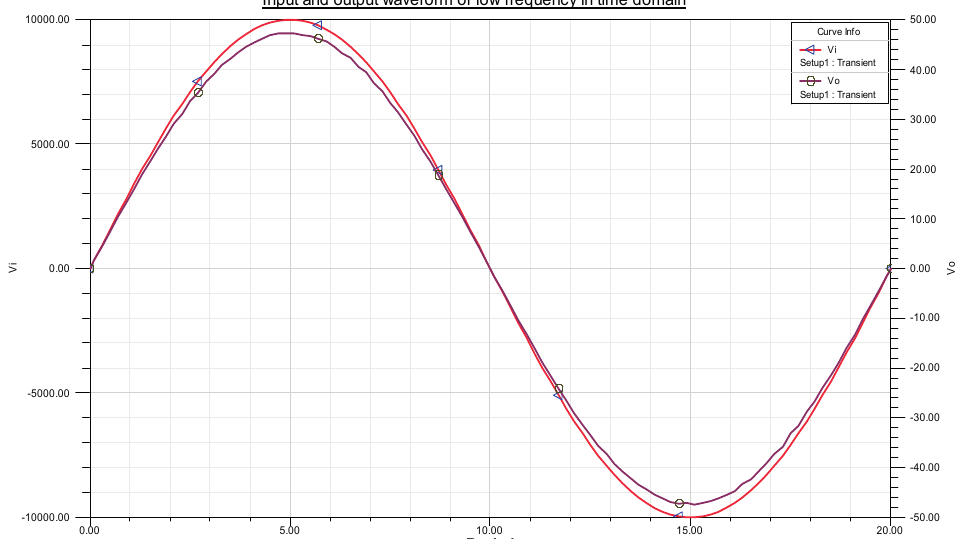
Figure 9. Input and output waveform of the